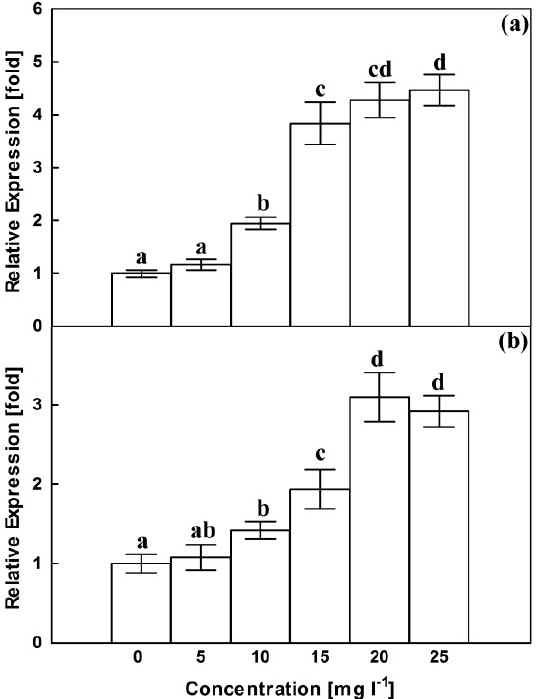
Figure 3. Effects of AgNPs at concentrations of 5, 10, 15, 20 and 25 mg L − 1 on relative expression of CrMPK3 gene ( a ) and STR gene ( b ) of C. roseus cell suspension cultures. Means ± standard deviations (SDs), n = 3, Values followed by the same small letter within each column are not significantly different at p ≤ 0.05.